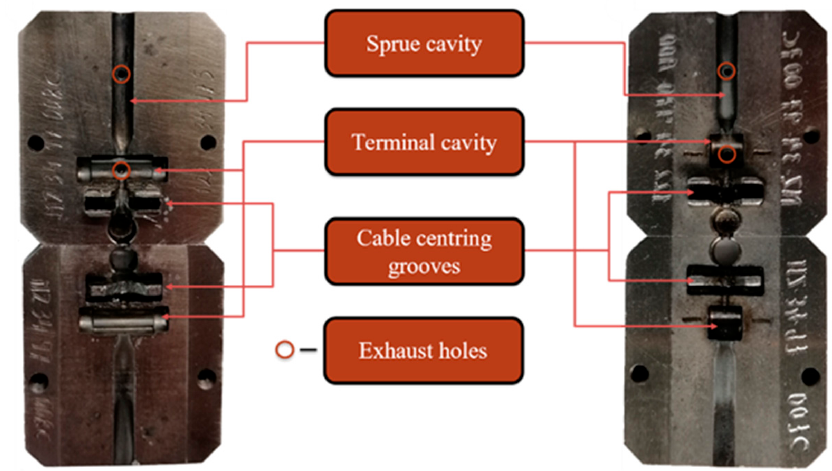
Figure 9. Details of the molds, terminals model 75 and model 70 shown.